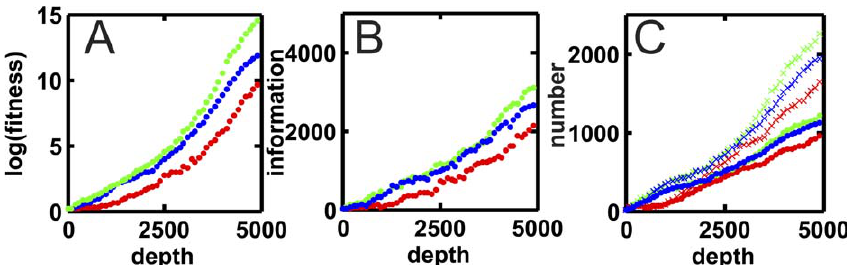
Figure 2. Evolution of Complex Networks (A) Log (base 10) of fitness along the line of descent, starting with the ancestor (phylogenetic depth zero) to the 5,000th organism on the line, for a static (green), quasi-static (blue), and a dynamic (red) environment. (B) Information content of genes (measured in base pairs) along the linse of descent every 100 generations, colors as in (A). (C) Evolution of number of nodes (points) and edges (crosses) along the line of descent. Colors as in (A).